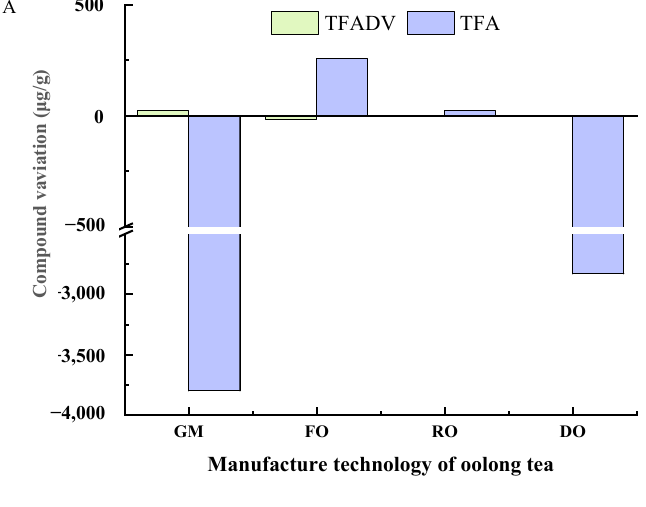
Figure 6. Cont -0.200.20.40.60.81 C16:0 C18:0 C18:1 C18:2 C18:3 C20:1 C24:0 C24:1 -0.6-0.4 Figure 6. Relation in FA and FADV contents during oolong tea preparation. GM, FO, RO, and DO indicate the green-making step, fixation, rolling, and drying technology of oolong tea, respectively; A indicates the variation in fatty acids content and their volatile derivative contents differed with the manufacturing technology; and B indicates the relation between the key FAs and MeJA during the green-making stage of oolong tea. * and ** are the relationships of different FAs with MeJA at p < 0.05 and p < 0.01, respectively. 3.4. Relationship of the Key FADV with Fatty Acids during Oolong Tea Green-Making Stage MeJA, the most important FADV, is a type of jasmonate with four isomers [33,34], which is only differentiated by nonpolar columns such as DB-5 and HP-5 columns. How- ever, in addition to MeJA, other FADVs analyzed by nonpolar columns have become a good reference. In our samples, only one MeJA structure was identified as previously published, and its content increased in the whole course of oolong tea preparation (Sup- plementary Materials, Table S1). Feng et al. reported that when the MeJA content was over -0.8